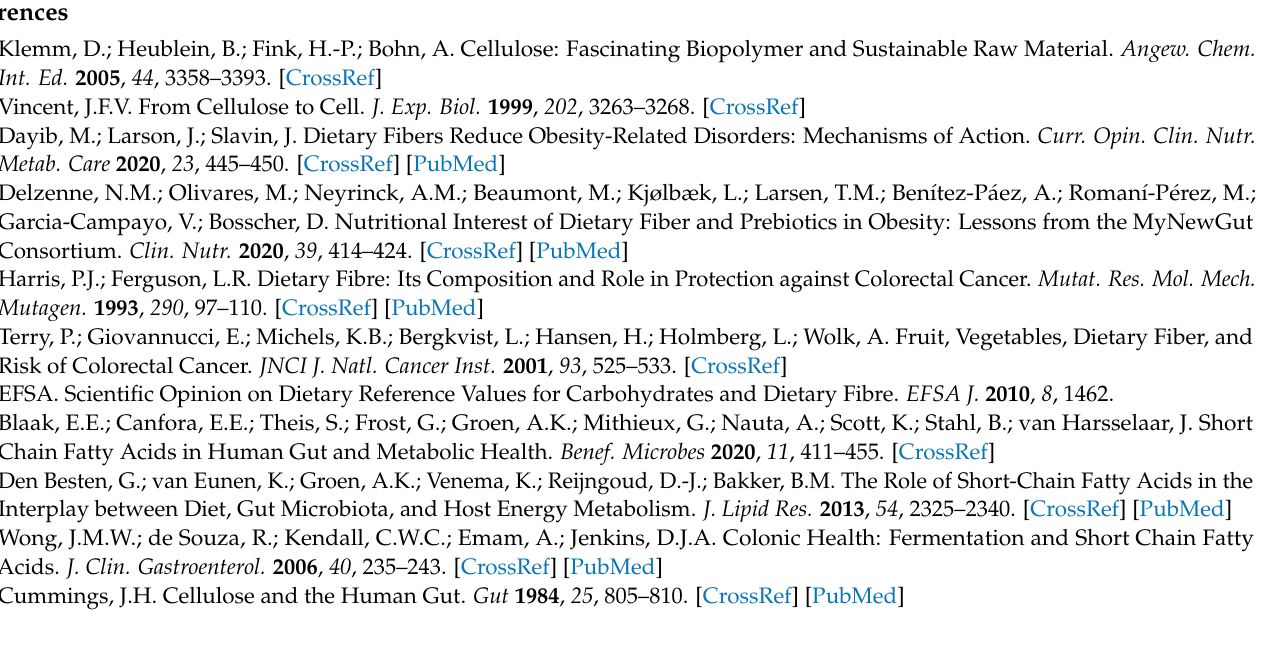
Figure A2. Acetate, butyrate and propionate concentrations, and the relative concentrations of branched SCFA (after 48 h) of cellulose-enriched fecal inocula in the second batch in vitro fermentation with pooled human feces, in function of incubation time. DCxx or ADCxx represents the fecal inoculum with the addition of a depolymerized cellulose or amorphized depolymerized cellulose with an average DP of xx. Different letters indicate significant differences between the samples at a certain timepoint ( p < 0.05).